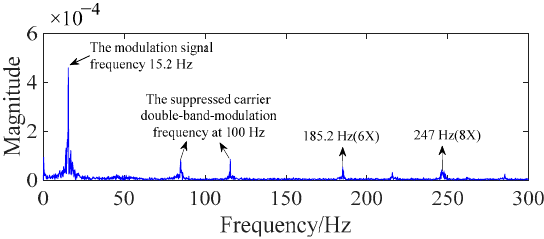
Figure 3. The spectrum of the normal grille controller.